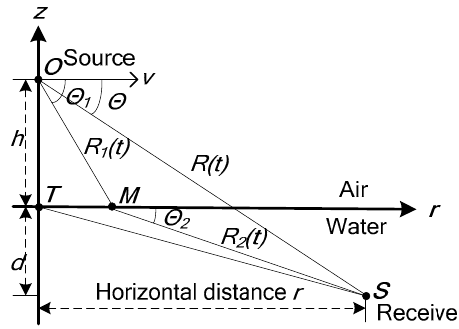
Figure 1. The direct refraction wave ray trace in the stratified medium.